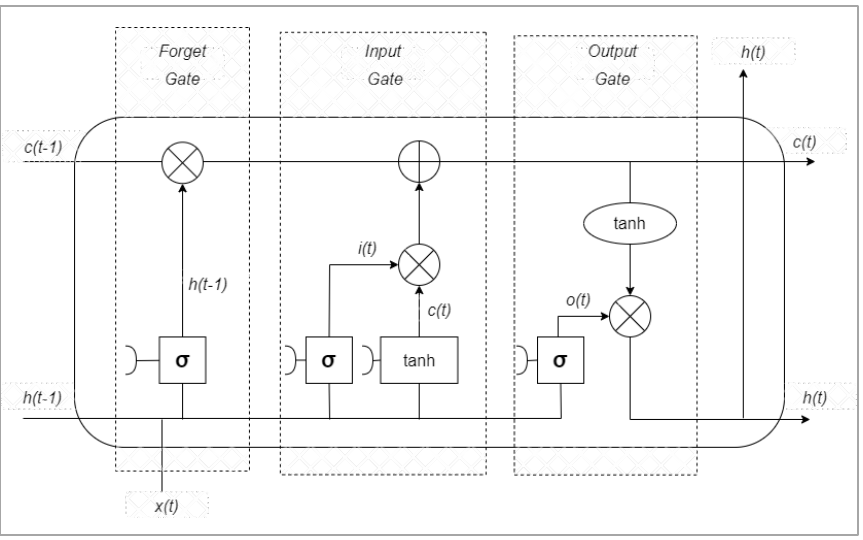
Figure 2. An illustration of LSTM cell.